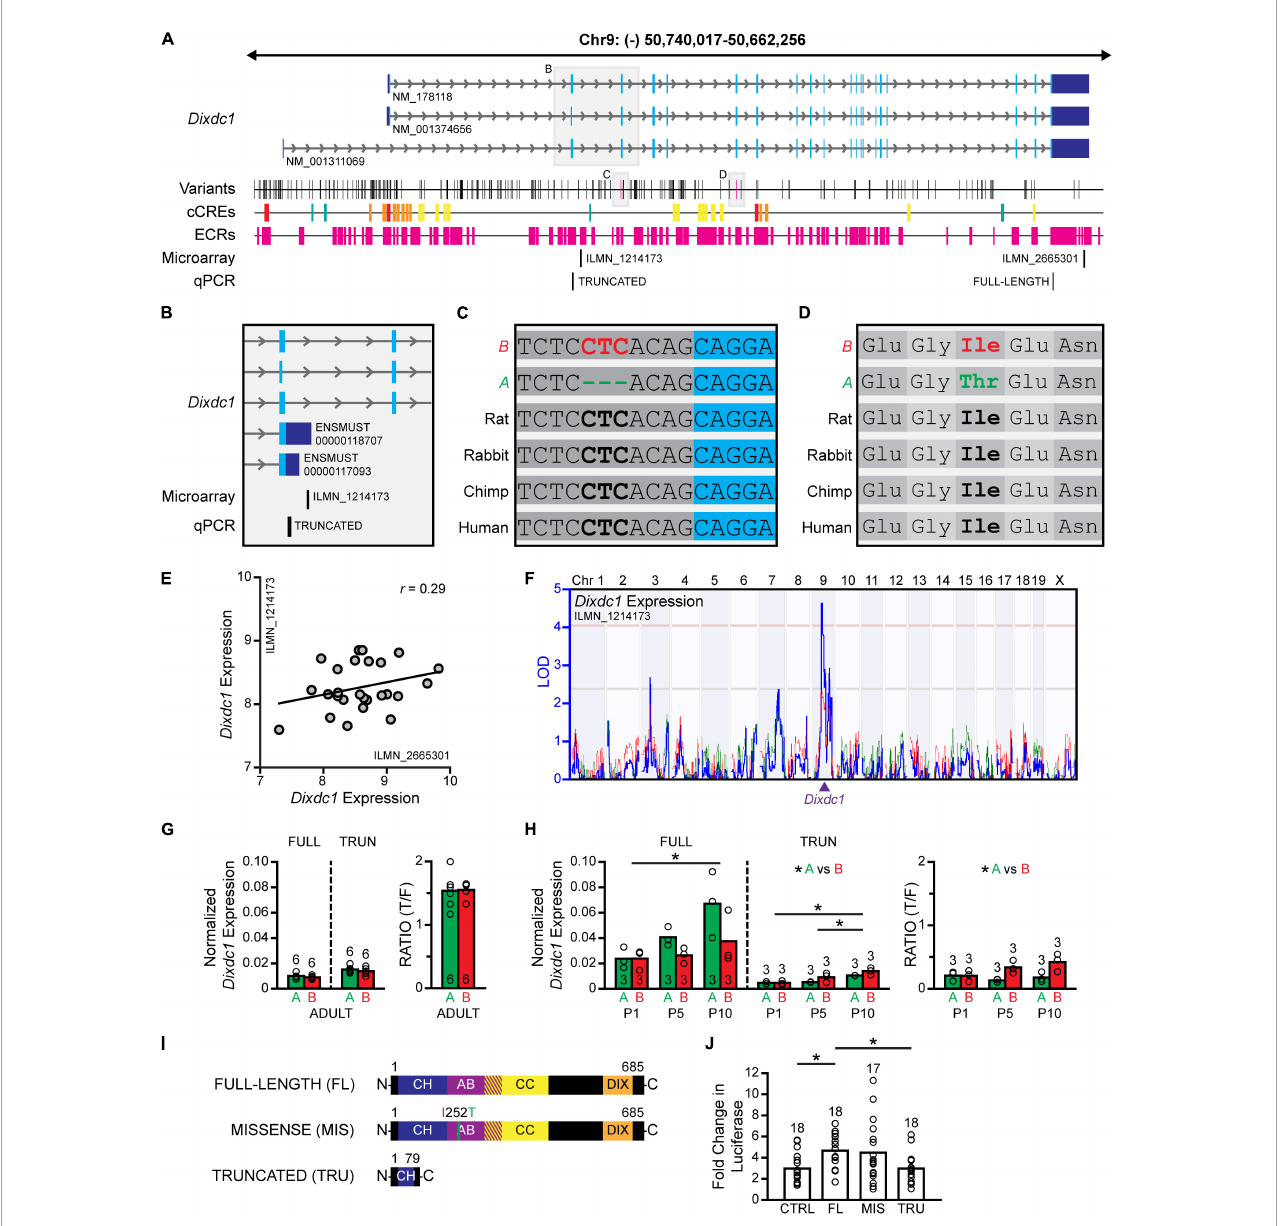
FIGURE7 Full-length and truncated Dixdc1 transcripts are differentially regulated during development. (A) The genomic structure of Dixdc1 , with conventions as in Figure 5A . Three transcripts are annotated in the RefSeq database, each with 20 exons and ∼ 77 kb in size. A/J and B6/J genomes are discriminated by many sequence variants, including one missense variant and one splice region INDEL of particular interest. The positions of two microarray probes are indicated, one probe recognizing the 3 (cid:48) UTR of the three annotated transcripts, and one probe that is complementary to a portion of the second intron. The positions of the qPCR primers are indicated at the very bottom. (B) Magnified region encompassing the second intron. Two transcripts that terminate within this intron were identified in the Ensembl database (release 102), one of which is recognized by the microarray probe. (C) The splice variant, a three-nucleotide INDEL, is in the second intron near the splice donor site. (D) The missense variant results in an amino acid substitution from nonpolar isoleucine to a polar threonine within the actin binding domain of Dixdc1 . B6/J carries the evolutionarily conserved sequence in each case. (E) Microarray analysis derived from adult whole eye mRNA (normalization described in Figure 5D ) confirms Dixdc1 expression using either the 3 (cid:48) UTR probe or the intronic probe in each RI strain, showing considerable (if largely uncorrelated) variation across strains. (F) Variation in the expression of truncated transcripts (ENSMUST00000118707) mapped a cis -eQTL, where the presence of the B haplotype at this locus was correlated with increased expression. (G) qPCR analysis reveals the truncated transcripts to be the dominant form in maturity, showing comparable levels of each transcript in both strains. (H) During postnatal development, the full-length transcripts are more prevalent, with expression of both transcripts increasing significantly as a function of age. Strain differences in expression were observed at later ages, yielding significant differences in the proportion of truncated to full-length transcripts, with B6/J retinas exhibiting a larger proportion than A/J retinas. (I) A luciferase expression assay compared the effectiveness of a full-length DIXDC1 isoform (NP_835219; translated from NM_001374656), an identical DIXDC1 isoform but now containing the missense mutation, and a truncated DIXDC1 isoform similar to that expected to be translated from the truncated transcripts, upon DVL2-mediated β -catenin signaling. Functional domains were determined from UniProt (uniport.org) annotations; CH, calponin homology domain; AB, actin binding domain; CC, coiled coil domain; DIX, DIX domain. (J) The missense isoform showed no functional effect of the mutation, augmenting β -catenin signaling to similar levels as full-length DIXDC1, while the truncated isoform was ineffective at modulating β -catenin signaling in either direction, with luciferase expression levels identical to controls. n = the number of adult retinas in panel (F) , the number of pooled samples from postnatal retinas in panel (G) , and the number of wells in panel (H)